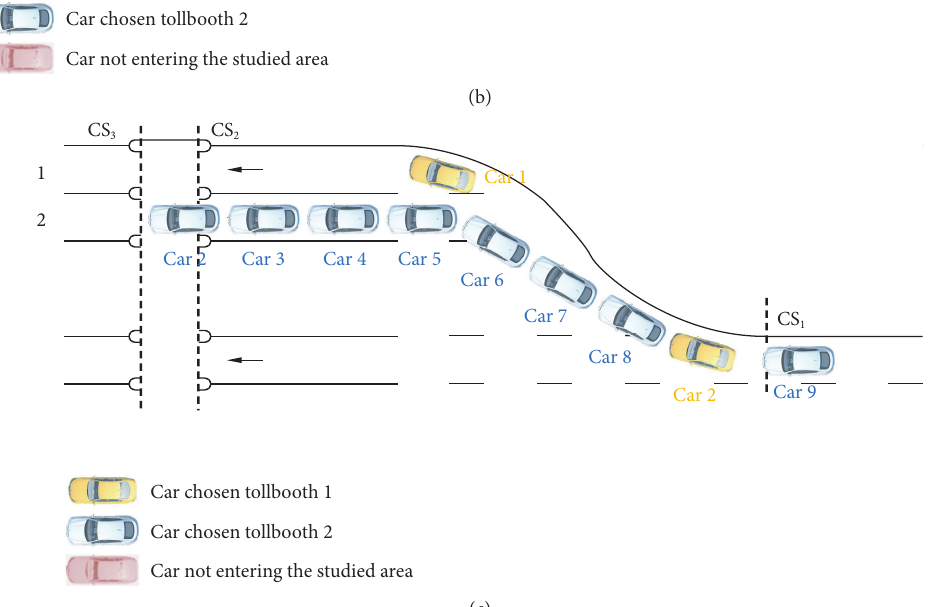
q B , newly arriving car 1 is a , q 2 ( t a ) ≥ 2 , newly arriving car 2 is blocked. (c) At time t c , 2